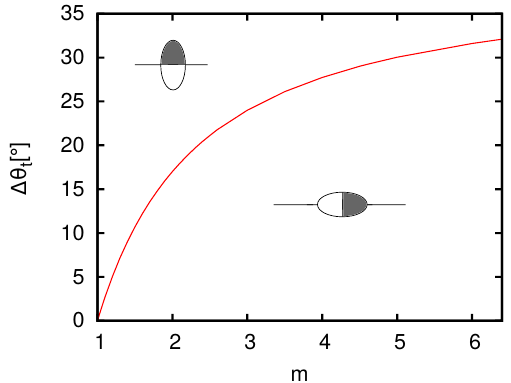
Figure 2. The phase diagram ( ∆ θ t - m ) obtained from the “simplified Janus model”. In the area above the line, the upright orientation is the stable state whereas below the line, the particle orientation parallel to the interface is the stable state. The line represents Equation (16).